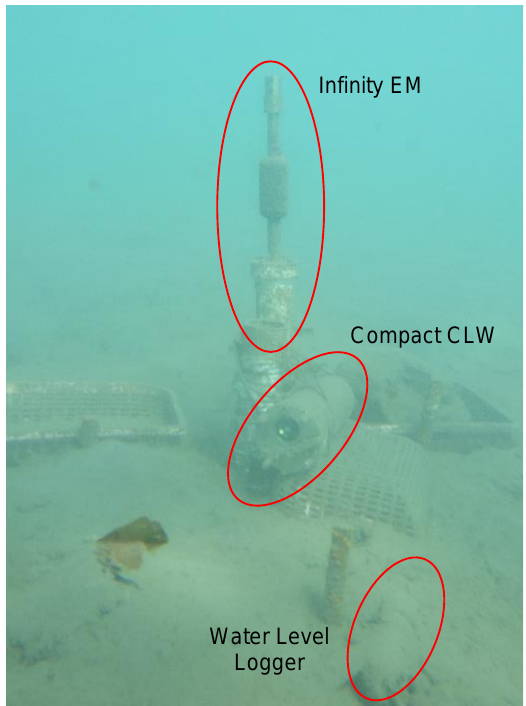
Figure 2. Photo of the deployed bottom-mounted set-up near